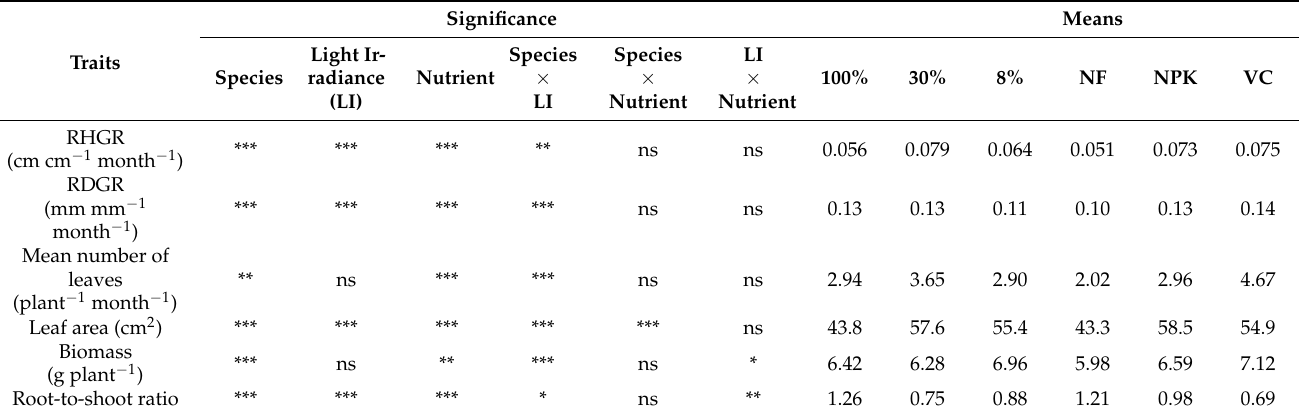
Table 1. The effects of light irradiance and nutrient amendments on morphological growth character- istics in two Shorea